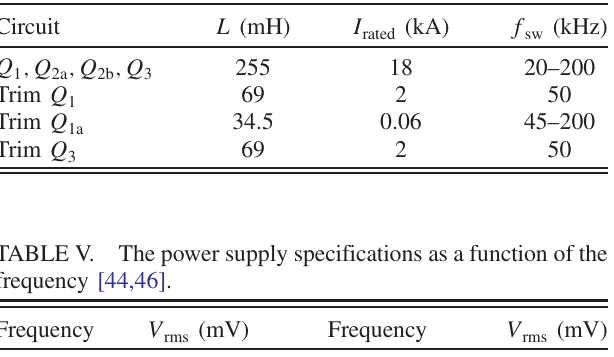
of the inner triplet circuits under sw